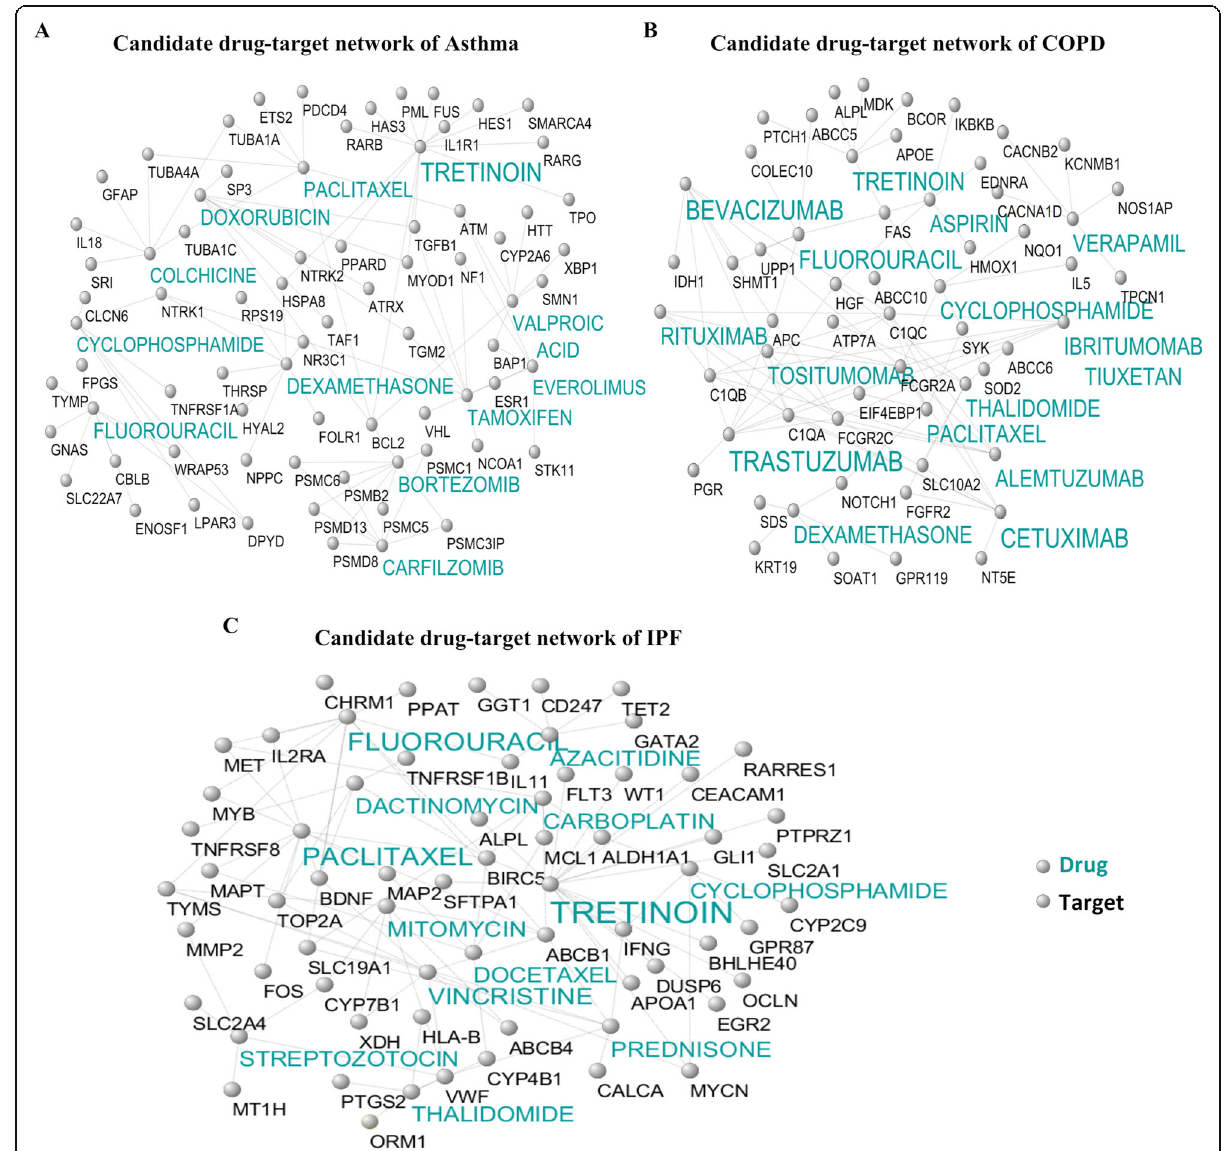
Fig. 7 Candidate disease-specific drug-target networks. Label targets and drugs are colored with black and turquoise, respectively. The size of drug letters reveals the degree of drug. a Candidate drug-target network of asthma, b Candidate drug-target network of COPD, and c Candidate drug-target network of